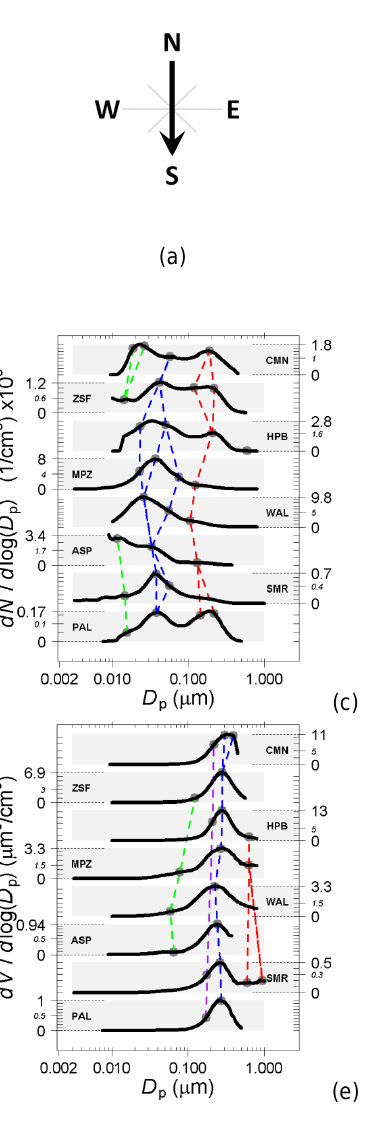
Fig. 11. Case study 4 (north to south). Temporal development of the particle size spectra plotted along the 5-day back-trajectory shown in 3 plotted green/red from midnight to midnight on the particle number (PN) emission map shown in (b) , starting at PAL on 12 October 2009 and arriving at CMN on 17 October 2009 at 18:00. Spectra collected from the nearest site to the air mass path are plotted in (c, e) . The peak fitted the modal diameters and area of each of these curves is shown in (d, f) . The middle panels correspond to the metrics derived from the number spectra and the lower panels correspond to the metrics derived from the volume spectra. The dotted lines in (c) and (e) are primarily to guide the eye, rather than being proposed as a firm causal